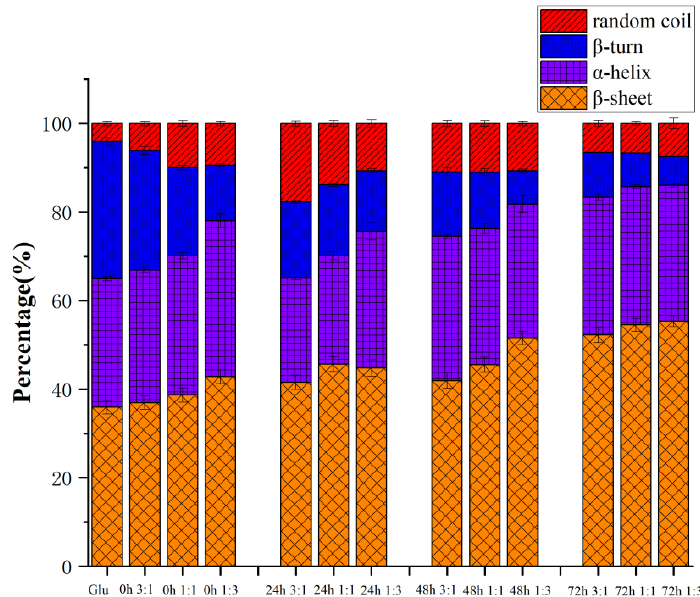
Figure 5. The secondary structure of gluten, mixtures, and conjugates, respectively. The results with different letters were significantly different ( p < 0.05).